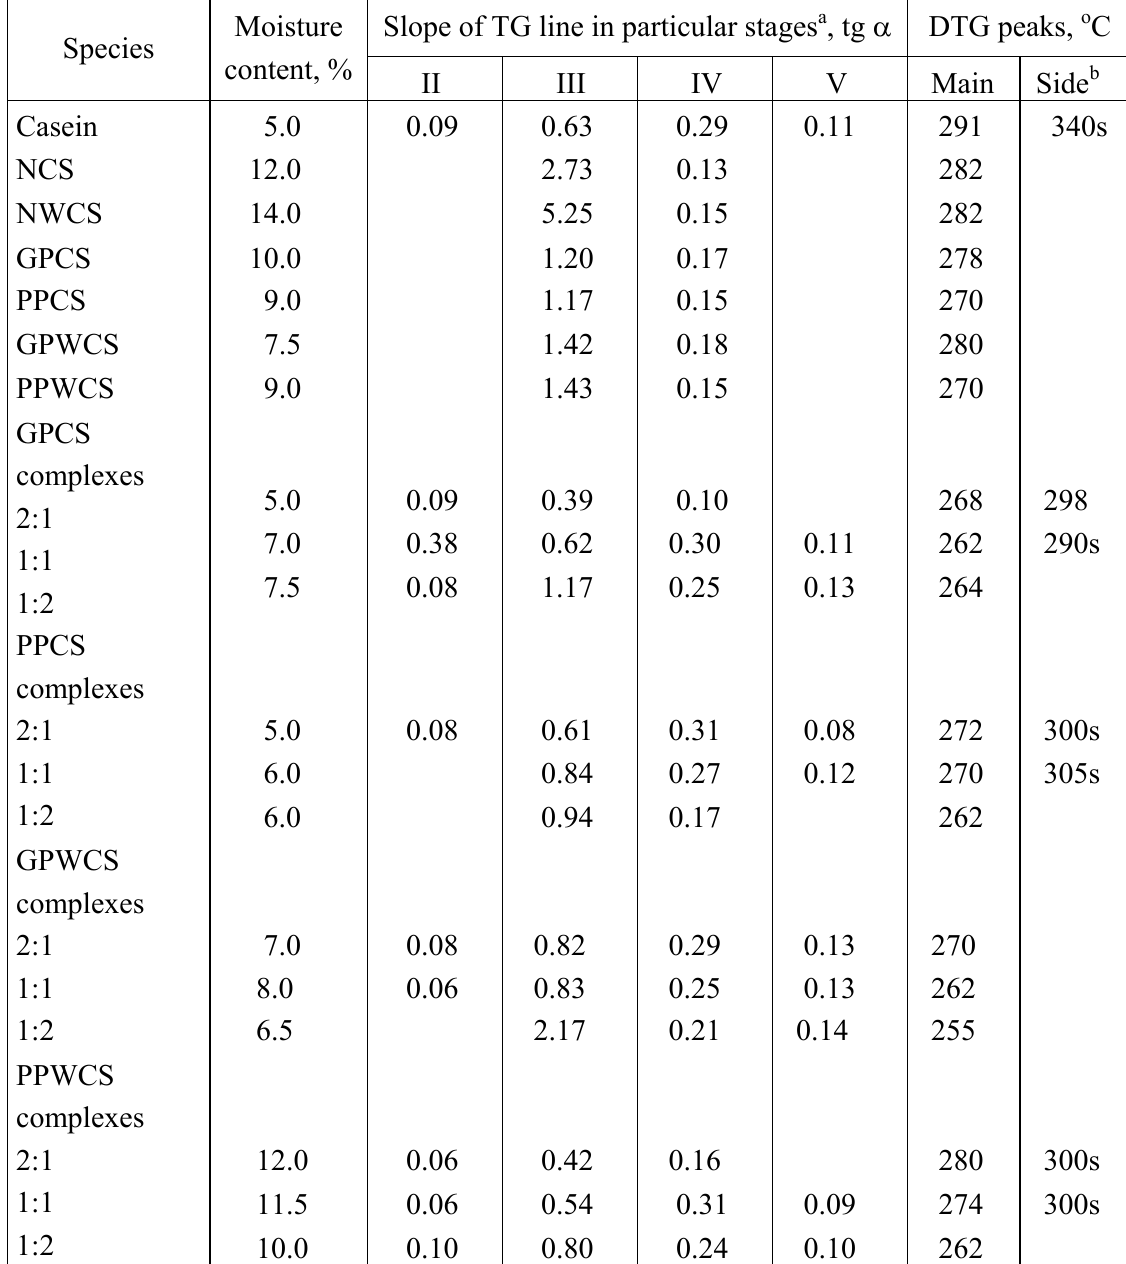
Table 6. Shortened thermal (TG/DTG) characteristics of casein, native corn (NCS) and waxy corn (NWCS) starches, phosphated granular corn (GPCS) and pasted corn (PPCS), granular waxy corn (GPWCS) and pasted waxy corn (PPWCS) starches and their casein complexes. Slope of TG line in particular stages a , tg α DTG peaks, o C Species